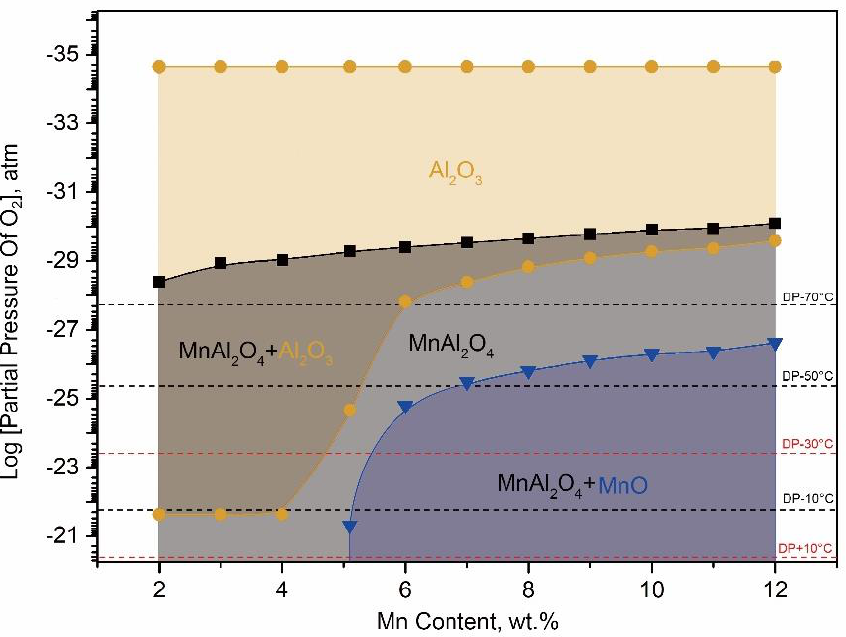
Figure 7. The dependence of the oxide stability on the equilibrium oxygen partial pressure and Mn content for the medium manganese lightweight steel. Table 2. Stable oxides under di ff erent dew points by